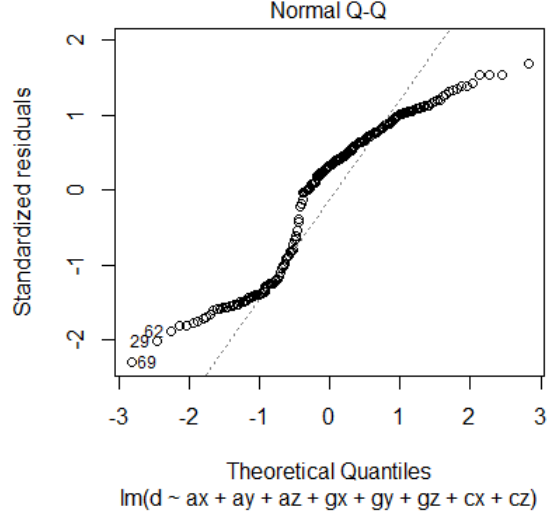
Figure 3. Normal Q-Q Plot.